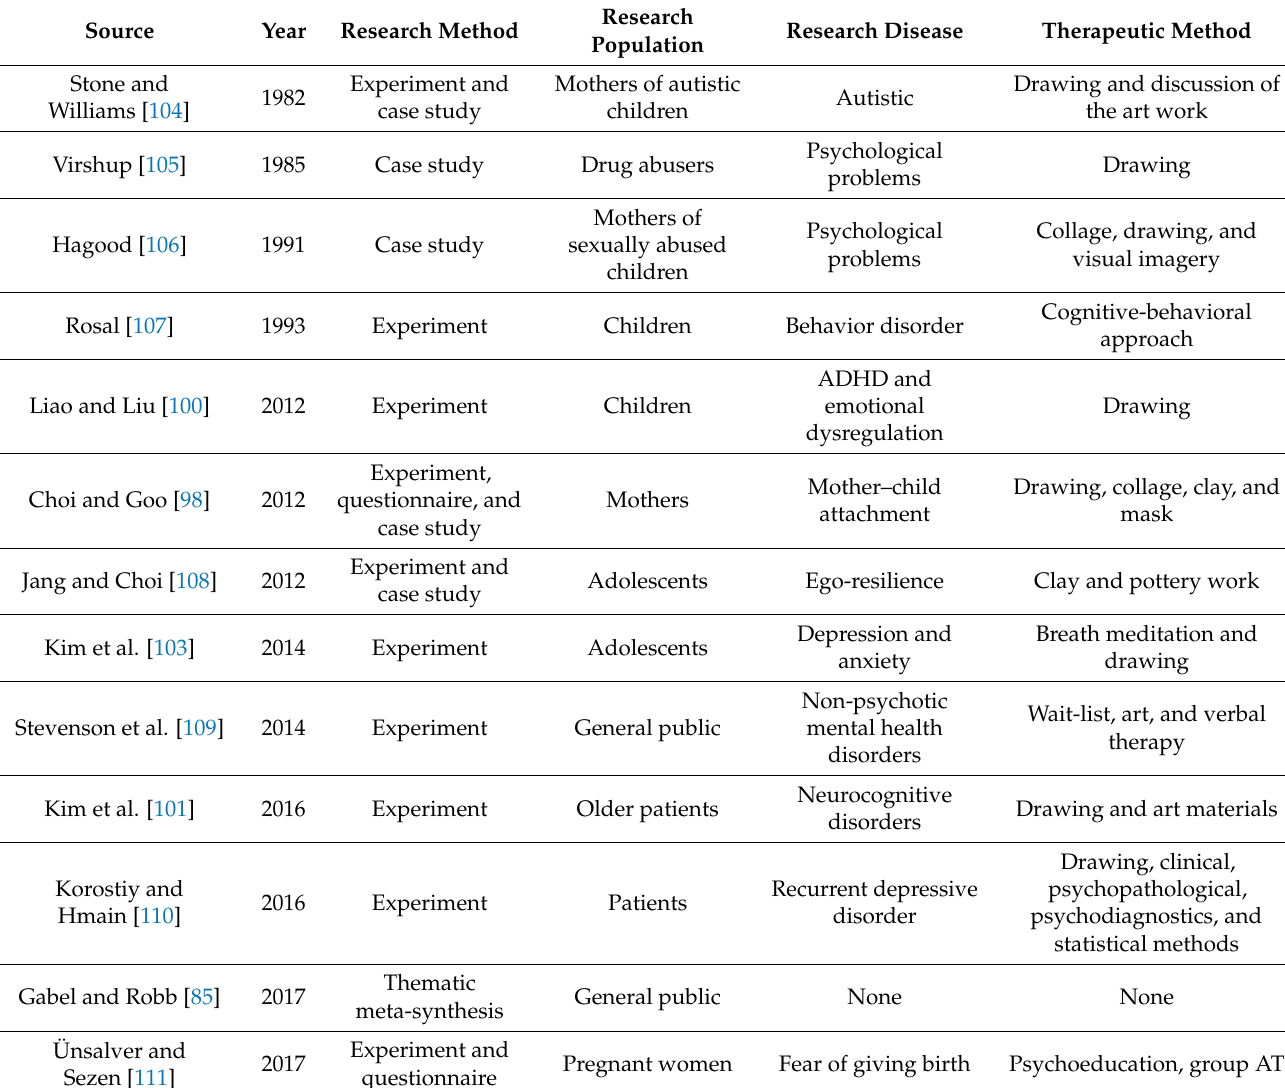
Table 4. The list of group AT studies for health and well-being (devised by the